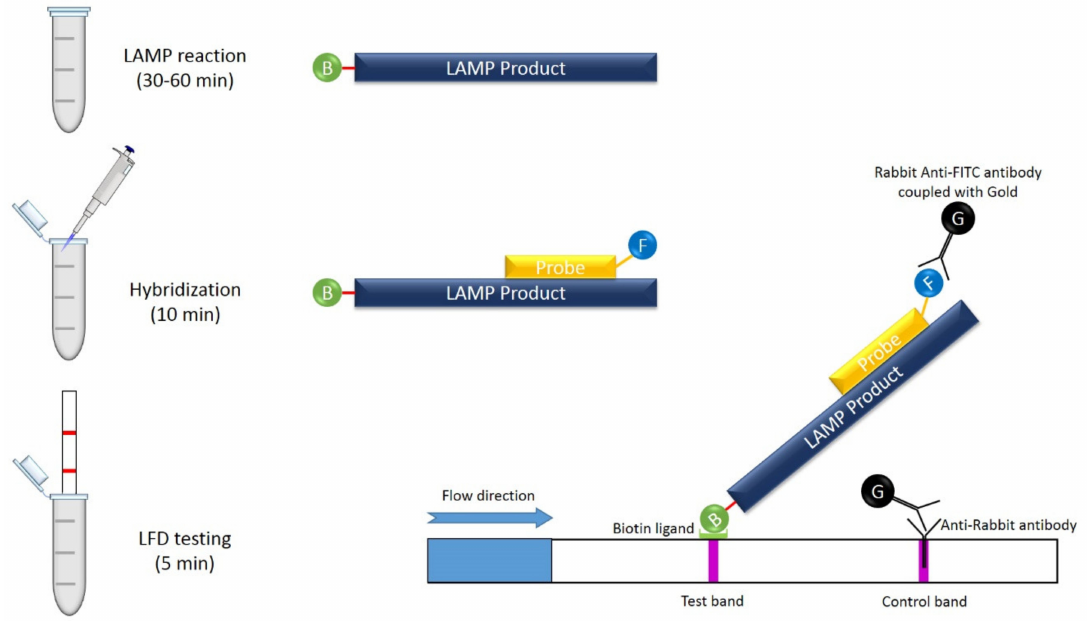
Figure 6. LAMP combined with lateral flow assay (LFA): the LAMP reaction is performed using a biotinylated forward inner primer (FIP) primer. After 30–60 min of initial incubation at